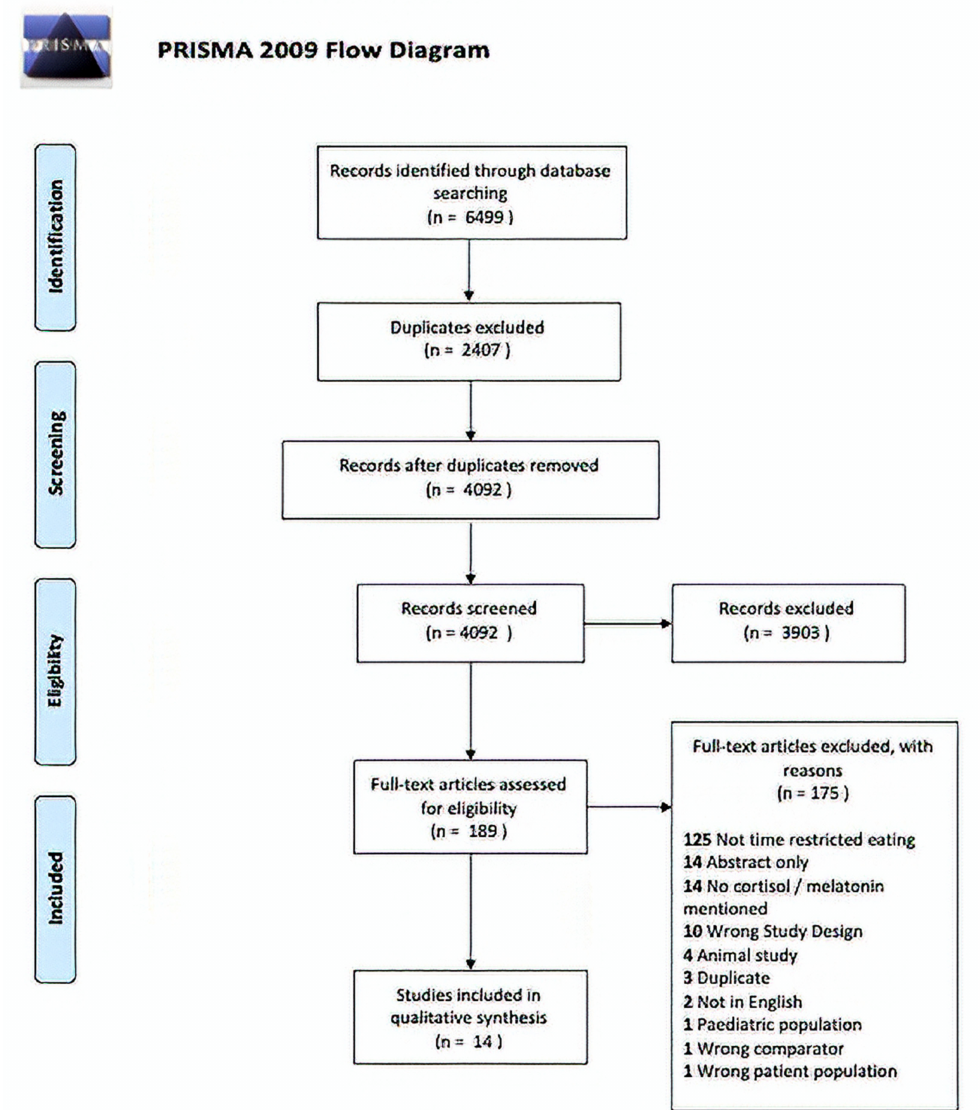
Figure 1. PRISMA 2009 Diagram for included